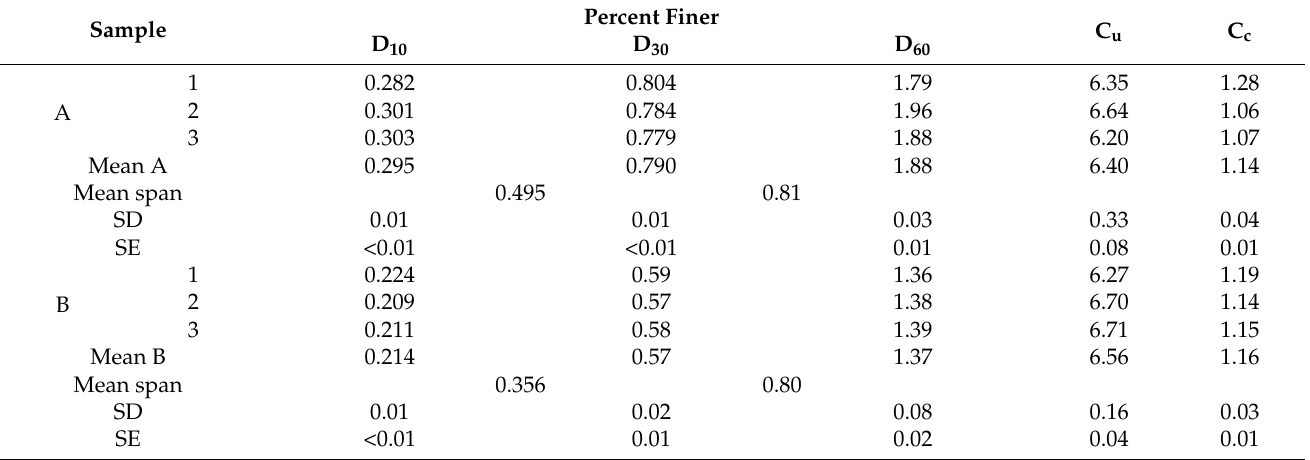
Table 2. Particle size corresponding to D N , uniformity coefficient (C u ), and curvature coefficient (C c ) for A and